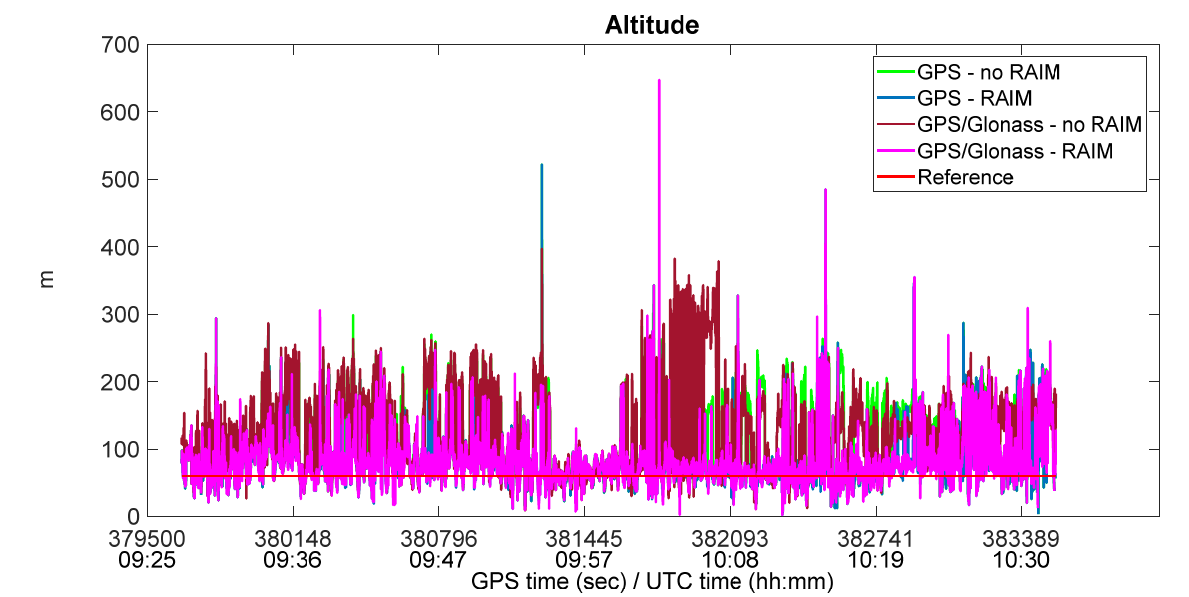
Figure 6. Vertical solution with Xiaomi Mi8, with and without RAIM application.